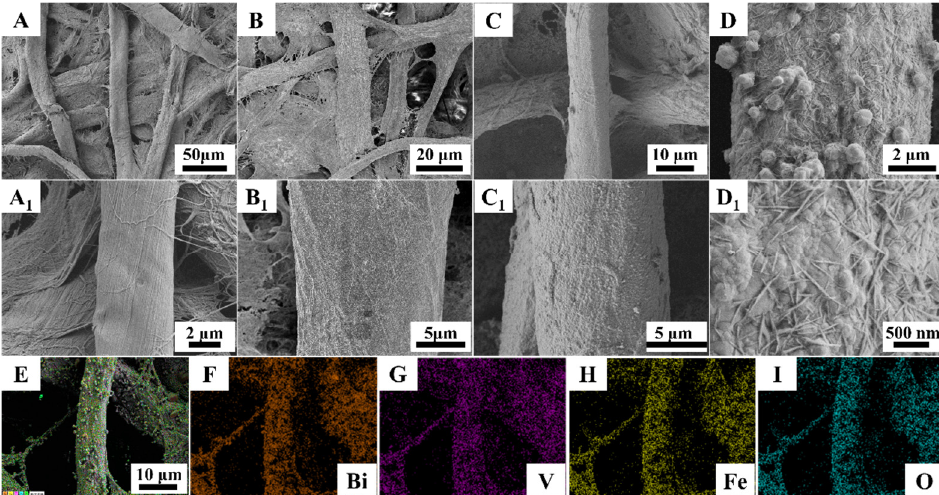
Figure 2. ( A , A 1 ) SEM images of bare cellulose fiber with different magnifications. ( B , B 1 ) SEM images of cellulose fiber modified with Au NPs. ( C , C 1 ) SEM images of paper-based BiVO 4 under different magnifications. ( D , D 1 ) SEM images of paper-based BiVO 4 /FeOOH under different magnifications. ( E – I ) The EDS elemental mapping images for Bi, V, Fe, and O elements.